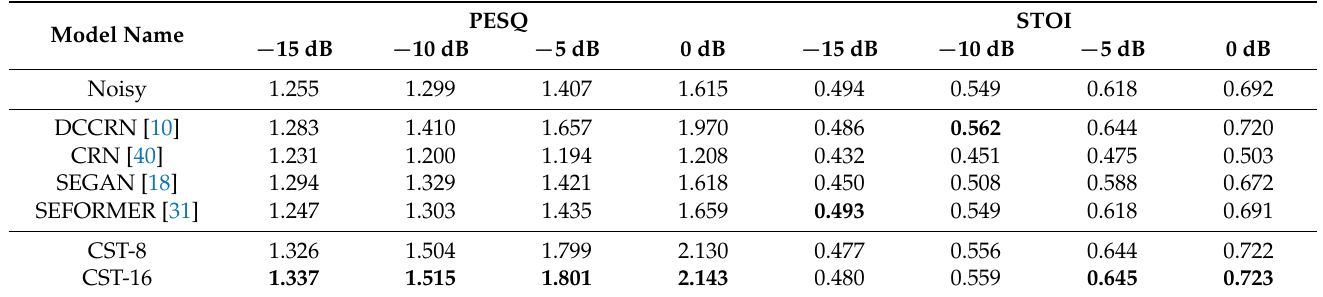
Table 3. Compare performance with other models in the VCTK test